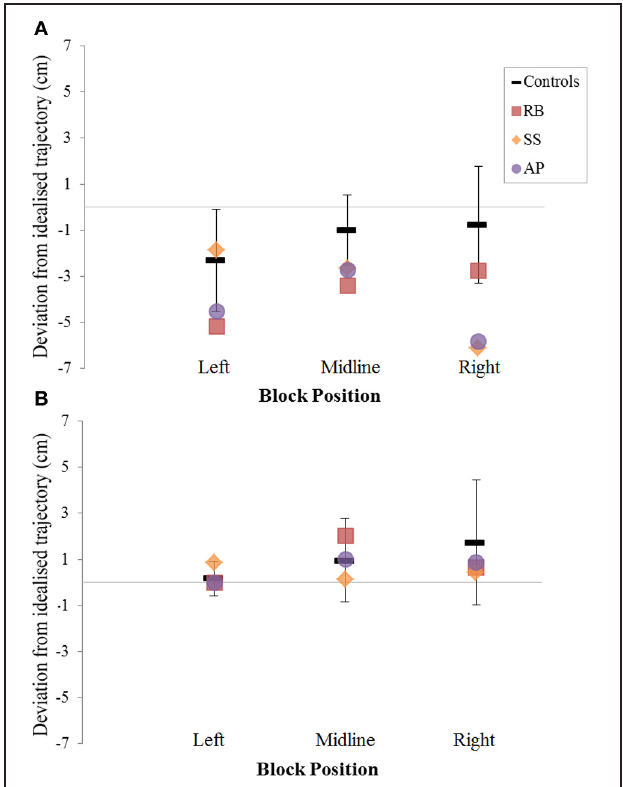
FIGURE 7 | The (A): leftward and (B): rightward reach path deviations in Experiment 2 for reaches made with the right hand.